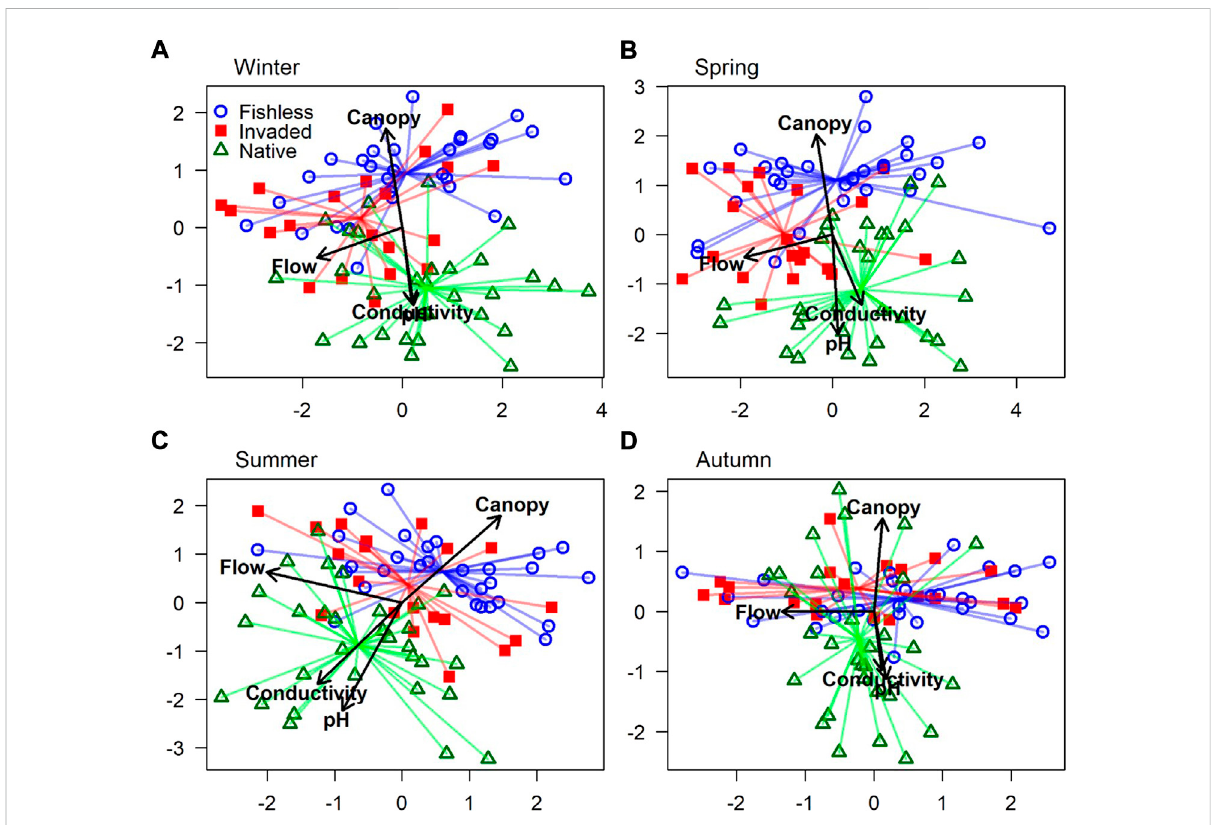
FIGURE 3 Bayesian ordination plots, for (A) . Winter, (B) . Spring, (C) . Summer and (D) . Autumn, based on latent variable 1 ( x -axis) and 2 ( y -axis) showing macroinvertebrate composition in river reaches without fi sh, invaded by trout, and inhabited by native fi sh. Ordered fl ow rate class, electroconductivity, percentage canopy cover and pH are illustrated with